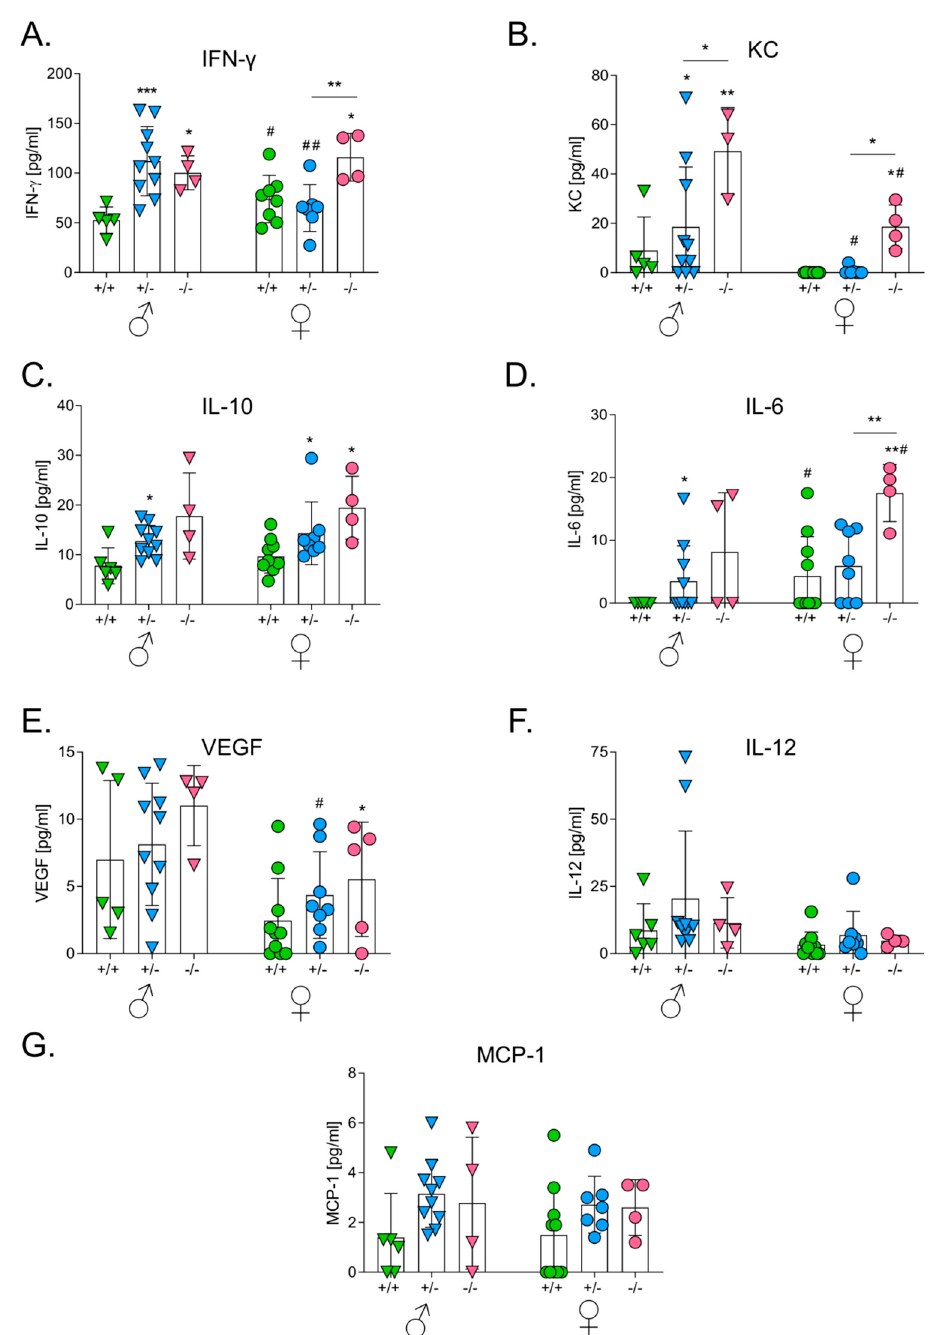
Figure 3. Effect of HO-1 expression in mice on concentrations of proangiogenic and proinflammatory cytokines in sera after intracutaneous injection with melanoma cells. ( A ) Concentration of IFN- γ . Cytometric analysis. ( B ) Concentration of keratinocyte chemoattractant (KC). ELISA. ( C ) Concentration of IL-10. Cytometric analysis. ( D ) Concentration of IL-6. Cytometric analysis. ( E ) Concentration of vascular endothelial growth factor (VEGF). Cytometric analysis. ( F ) Concentration of IL-12. Cytometric analysis. ( G ) Concentration of MCP-1. ELISA. Each bar represents mean ± SE ( N = 4–10; * p < 0.05, ** p < 0.01, *** p < 0.001 vs. HO-1 +/+ mice, # p < 0.05, ## p < 0.01 vs. ♀ ♂